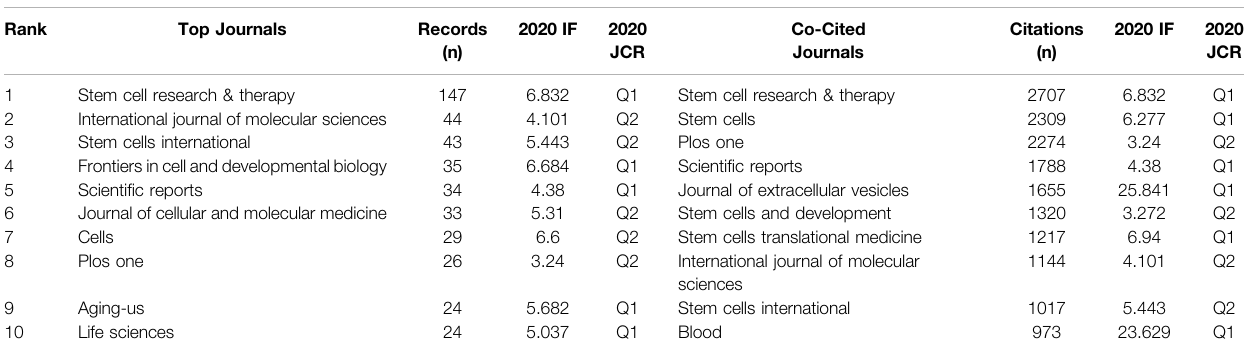
TABLE 2 | The top 10 most active journals and co-cited